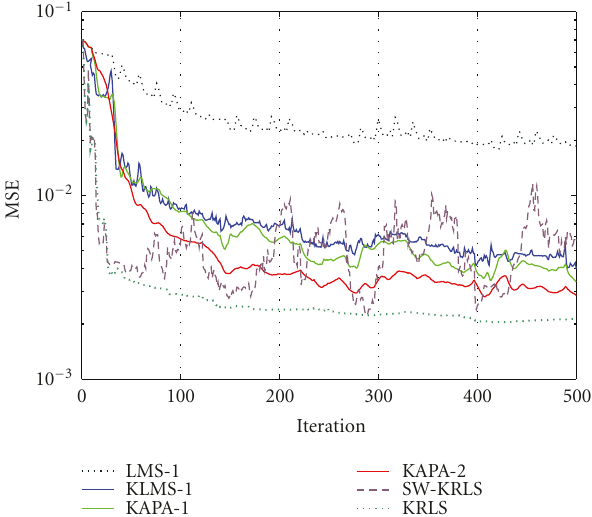
Figure 1: The learning curves of the LMS, KLMS, KAPA-1 ( K = 10), KAPA-2 ( K = 10), SW-KRLS ( K = 50), and KRLS.